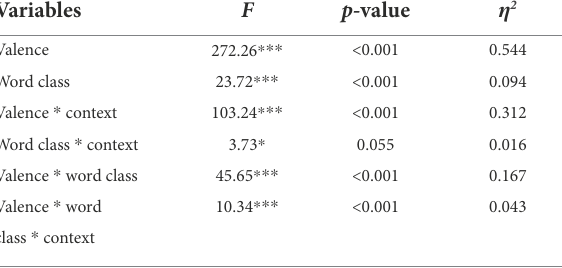
TABLE 1 Repeated-measures three-way ANOVA of valence, word class, and context.